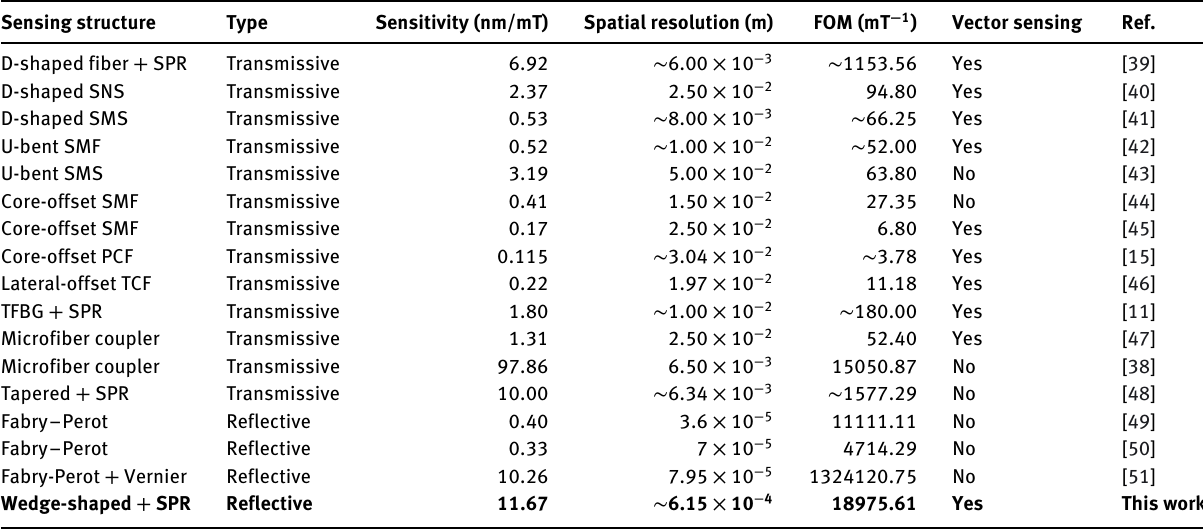
Table 1: Sensing performance of related fiber-optic magnetic field sensors. Sensing